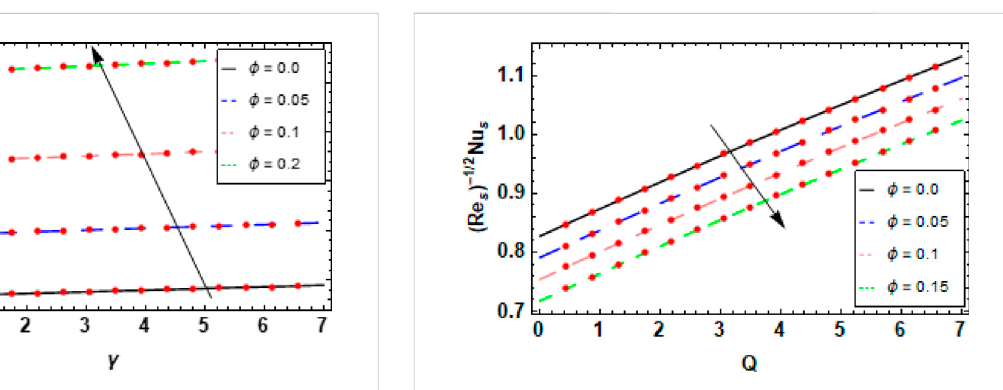
FIGURE 16 Effects of Q and ϕ on Nu s ( Re s ) − 1/2 .